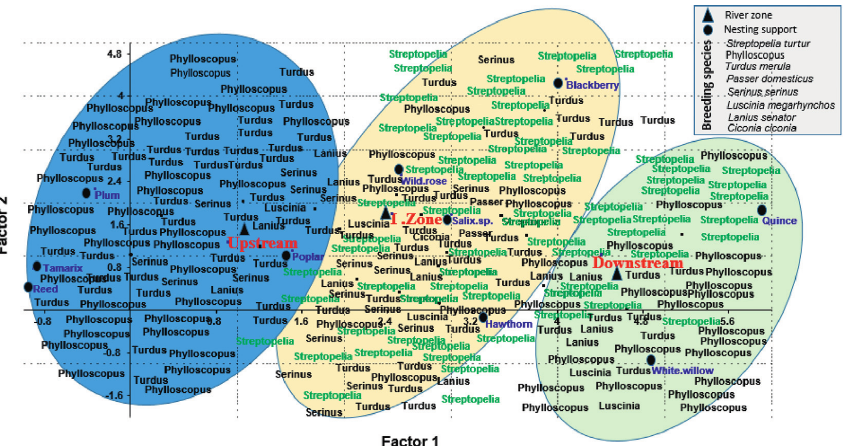
Figure 2: Distribution of nesting species (birds: Ciconia ciconia, Lanius senator, Phylloscopus bonelli, Luscinia megarhynchos, Passer domesticus, Serinus serinus, Streptopelia turtur , and Turdus merula ), used trees (nesting trees: plum, Tamarix , reed, poplar, wild rose, Salix , hawthorn, blackberry, white willow, and quince), and river’ zones (breeding habitats (rivers divided into three zones): upstream, in- termediate zone, and downstream) during breeding seasons between 2015 and